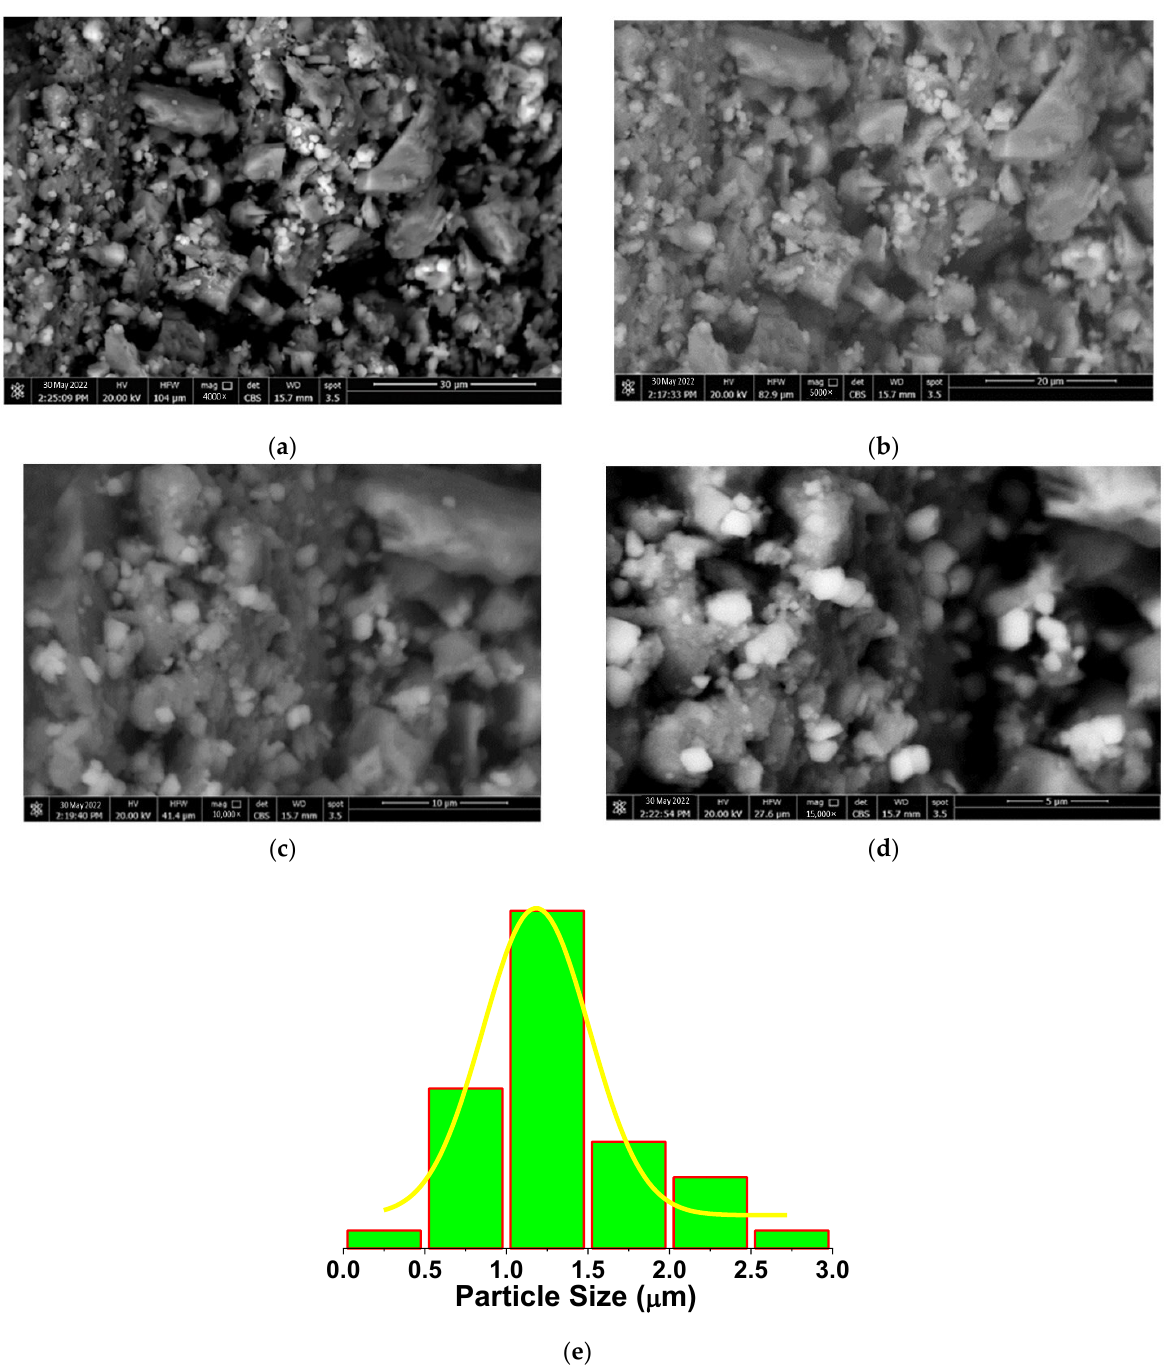
Figure 6. SEM micrographs of the EPSR4 at different magnifications, ×4000 ( a ), ×5000 ( b ), ×10,000 ( c ), ×15,000 ( d ), and the particle size distribution ( e ).